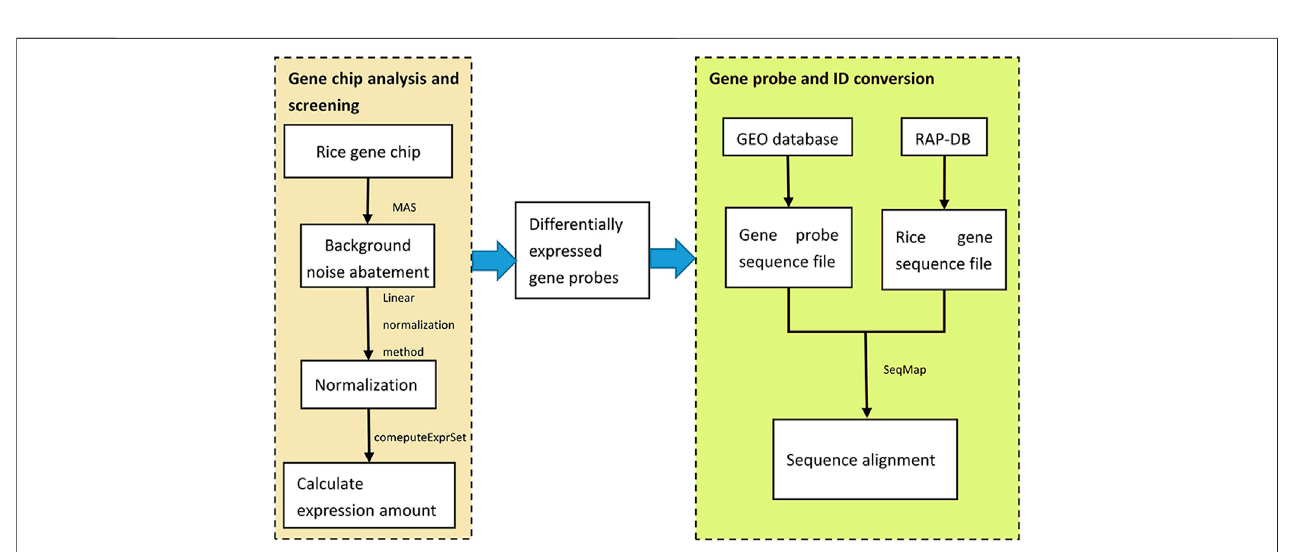
FIGURE 1 | Overall design route.